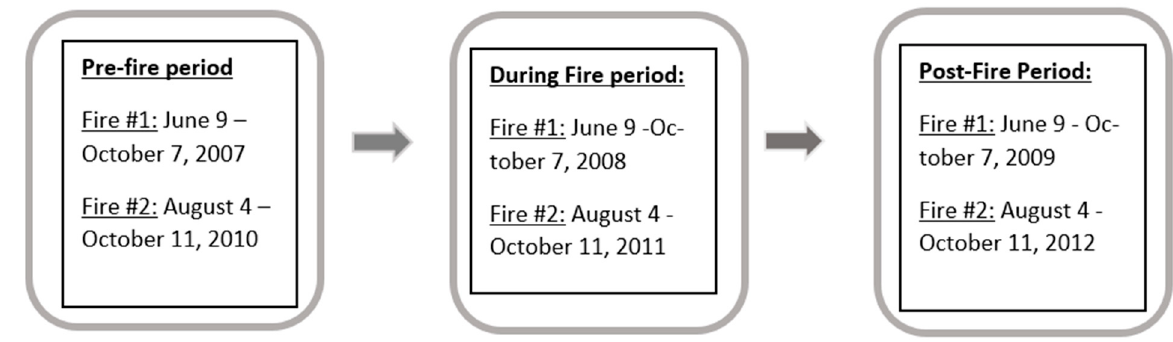
Figure 1. Patient dataset time periods of interest (January 2007–December 2012).